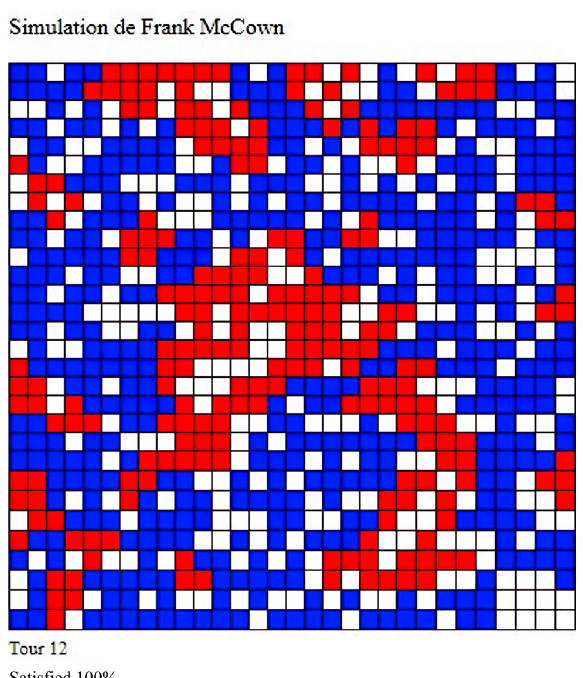
Fig. 12. Spatial and phenomenal segregation in Medea’s November 1st 1954 Square 1954.